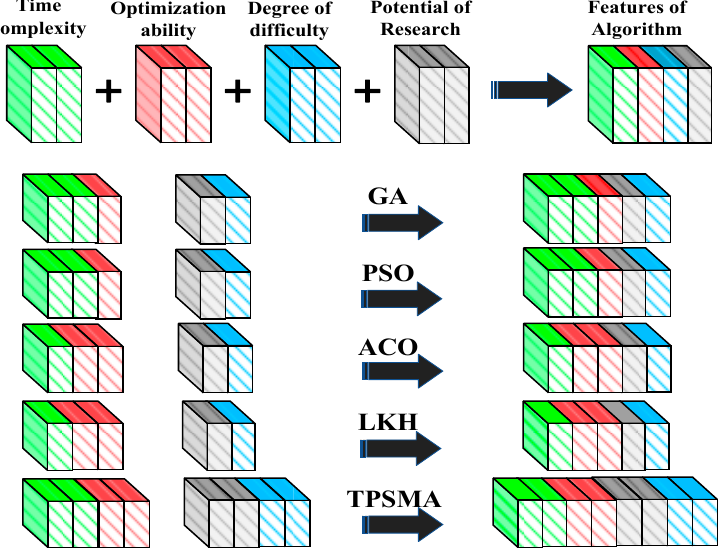
Figure 15. Comparison and analysis of algorithm characteristics.